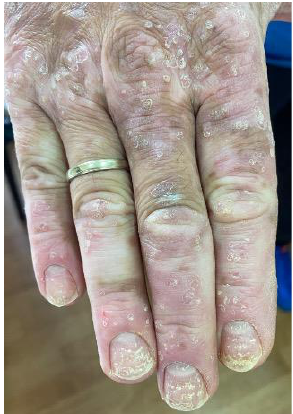
Figure 1. A melanoma patient developing plaque psoriasis, nail psoriasis and vitiligo after ICB treatment.